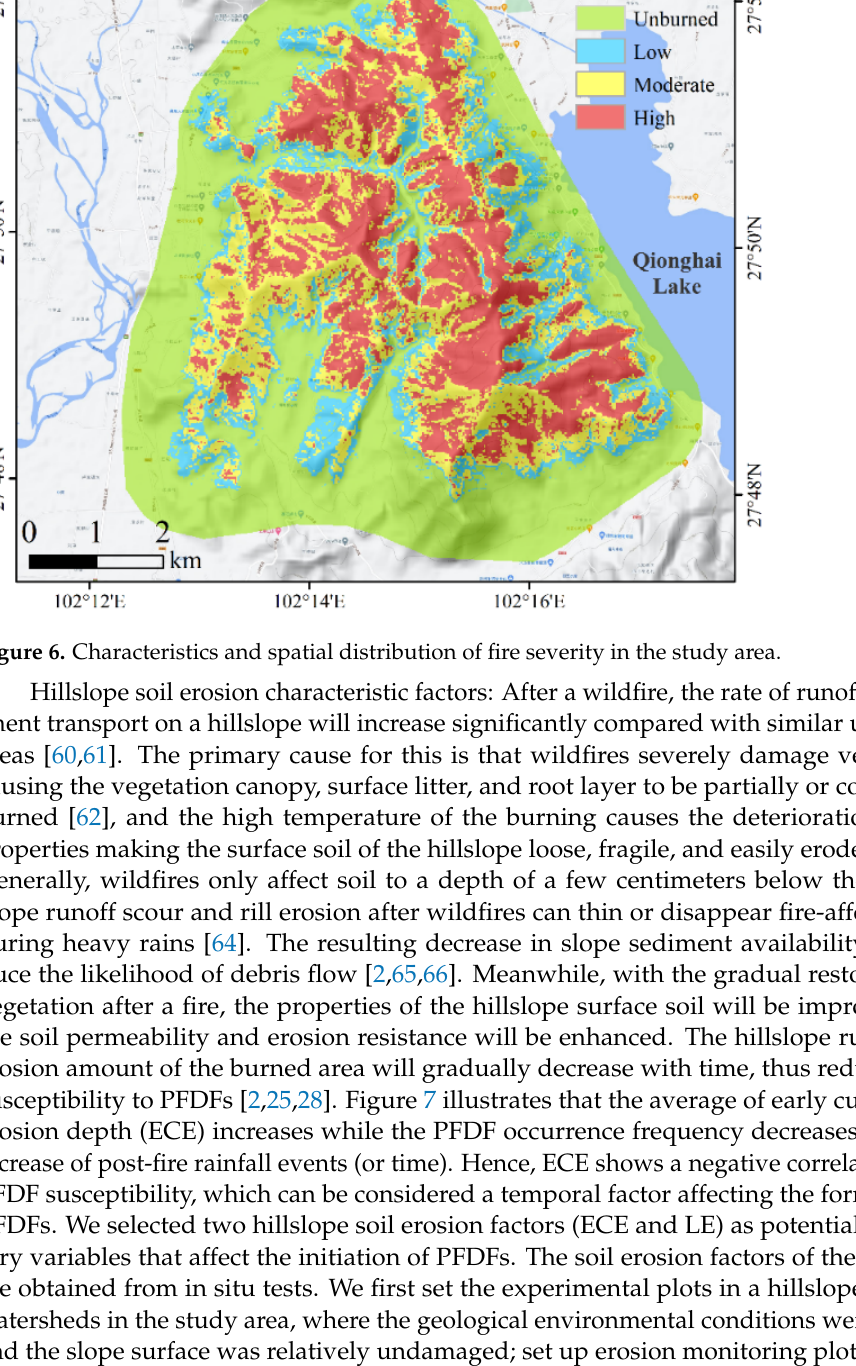
Figure 7. The temporal evolution laws of the average of ECE and occurrence frequency of PFDF in 27 rainfall events of the first rainy season after the fire in the study area.